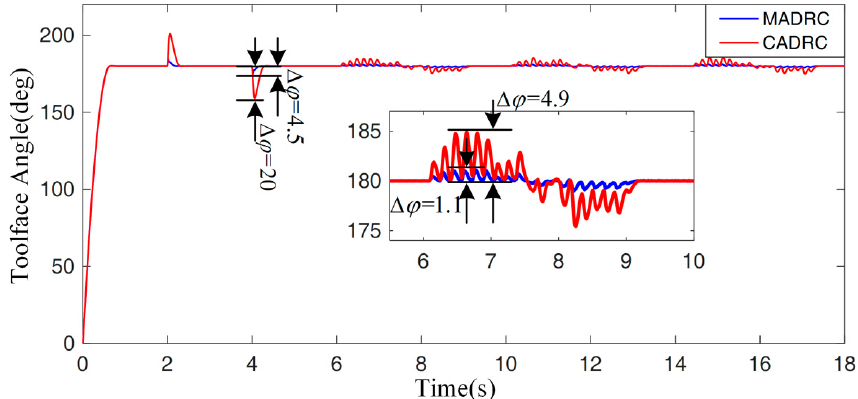
Figure 11. The toolface response curves.